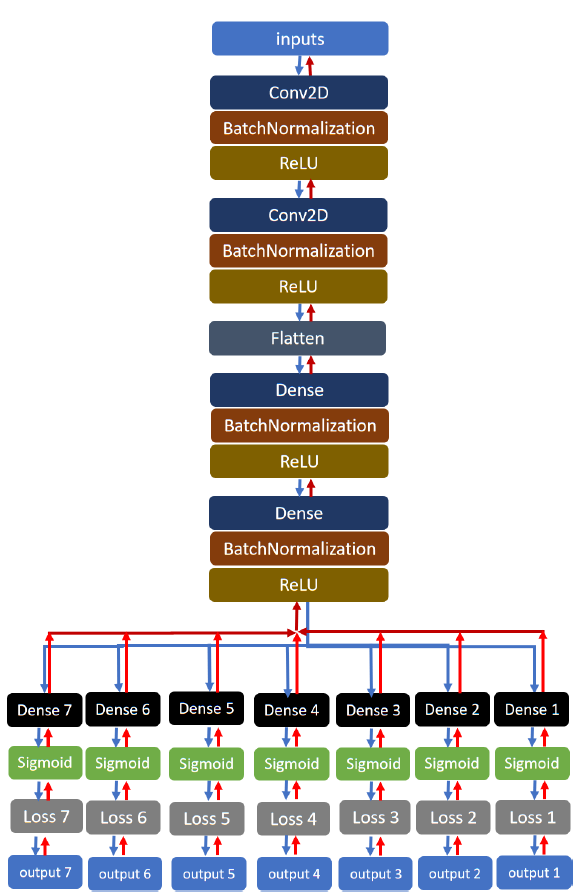
Figure 9. Proposed deep learning model architecture: common convolutional backbone shared across all